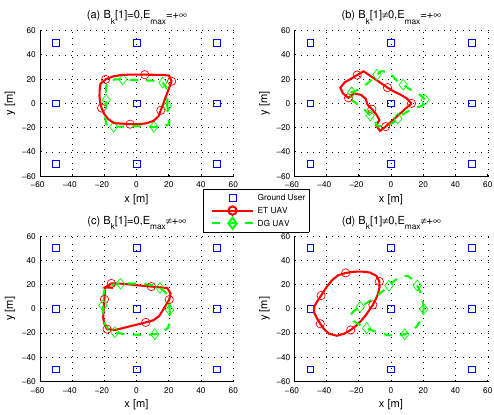
Figure 3. Optimized UAV trajectories when T = 30 s.